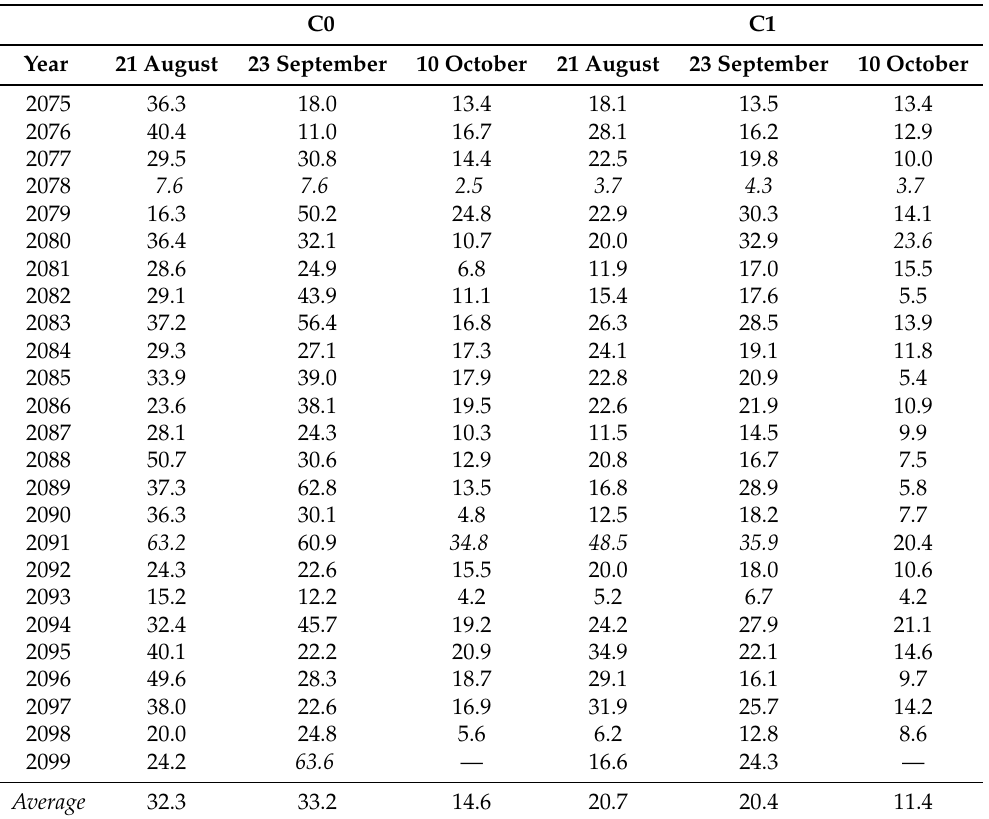
Table 1. Future time yields in tha − 1 for C0 and C1 SST-ensemble and for early, mid, and late planting dates. C0